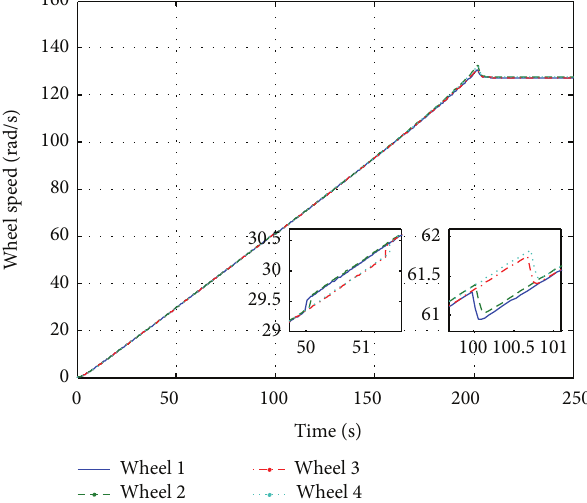
Figure 10: Adhesive coefficient of each driving